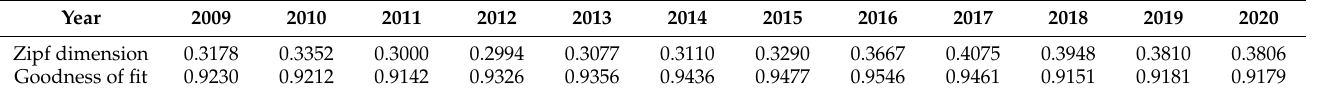
Table 1. Scale parameters of rank-size distribution of PIR in China during 2009–2020.